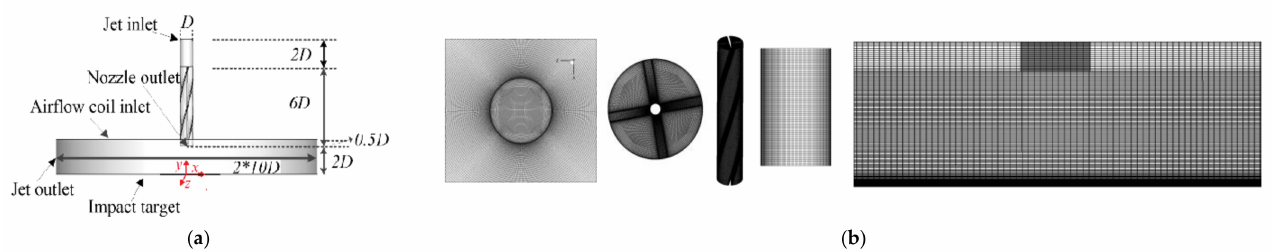
Figure 1. Computational domains and grid of a swirling impinging jet on a flat target: ( a ) computational domains, ( b ) computational